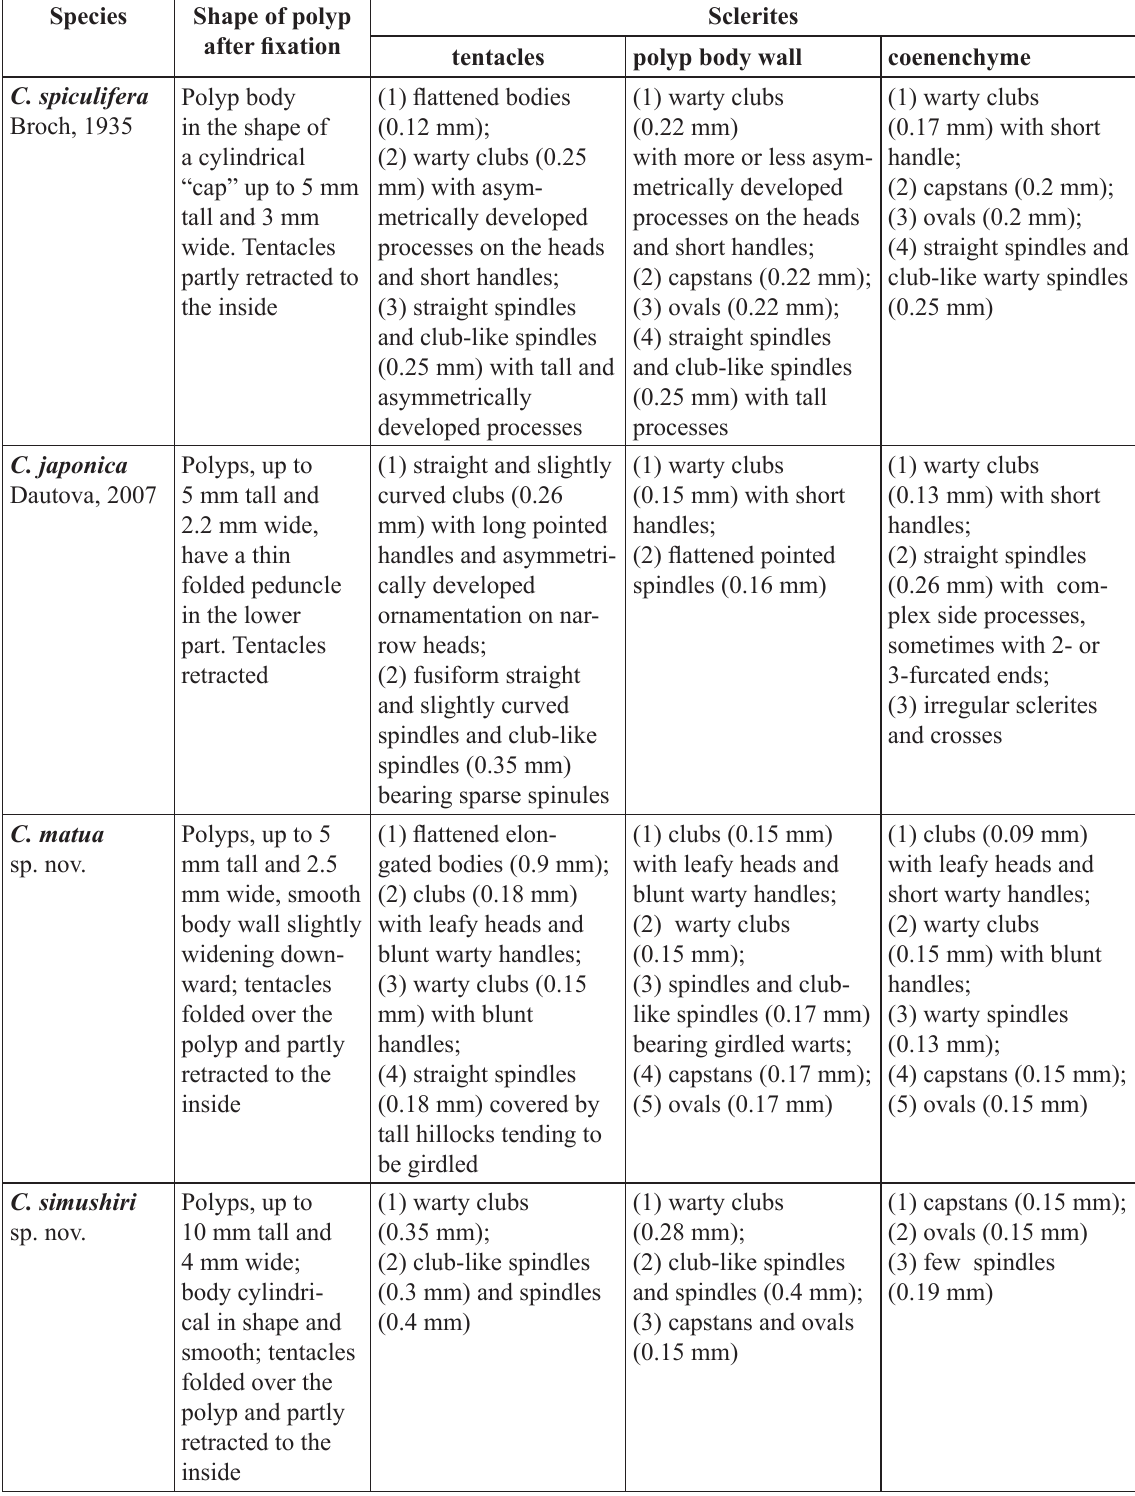
Table 1. Distinctive characters of species in the genus Calcigorgia Broch, 1935. The greatest length for the different types of sclerites is provided in